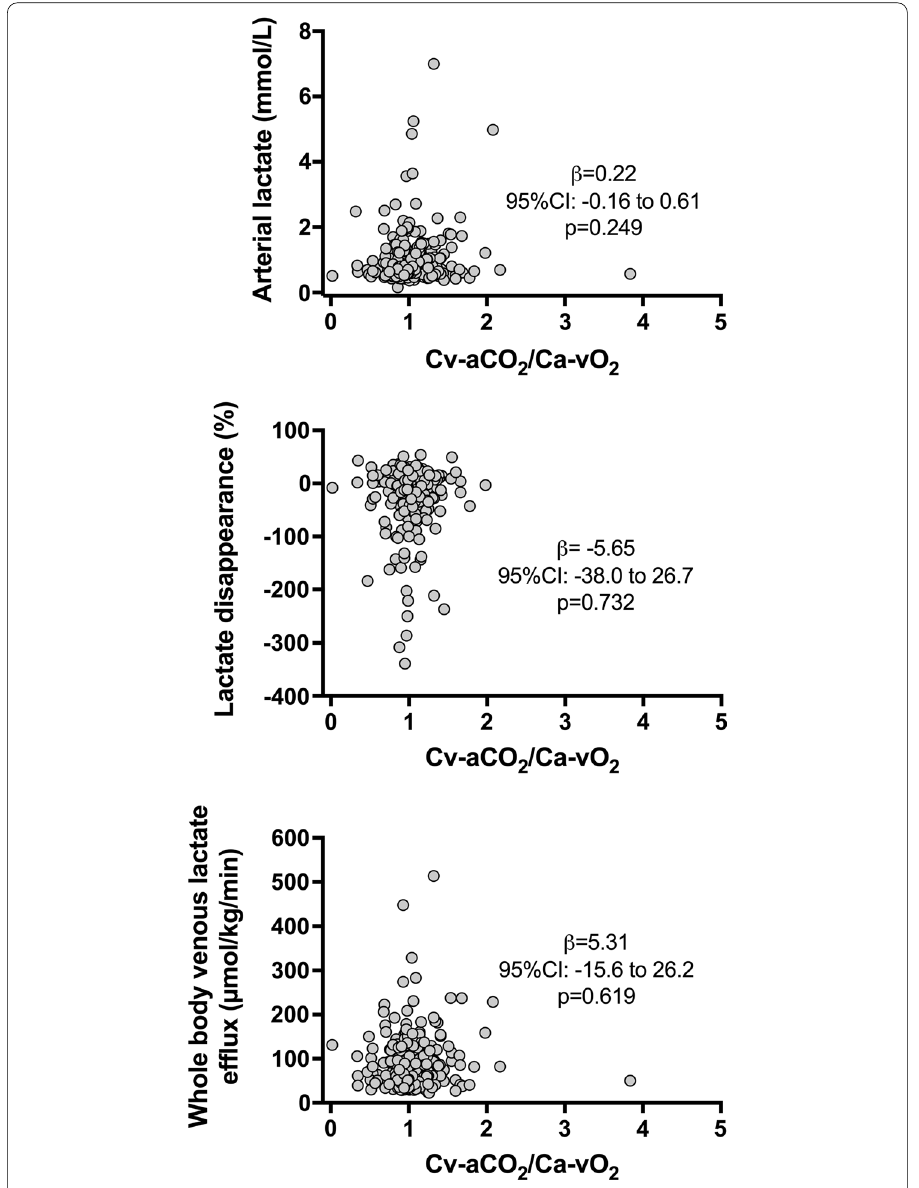
Fig. 1 Scatter plot between systemic venous–arterial CO 2 to arterial–venous O 2 content difference ratio (Cv-aCO 2 /Ca-vO 2 ) and arterial lactate, lactate disappearance and whole-body venous lactate efflux. β unstandardized coefficient, CI = venous O 2 content difference ratio, whole-body venous efflux concentration, lactate disappearance (%)